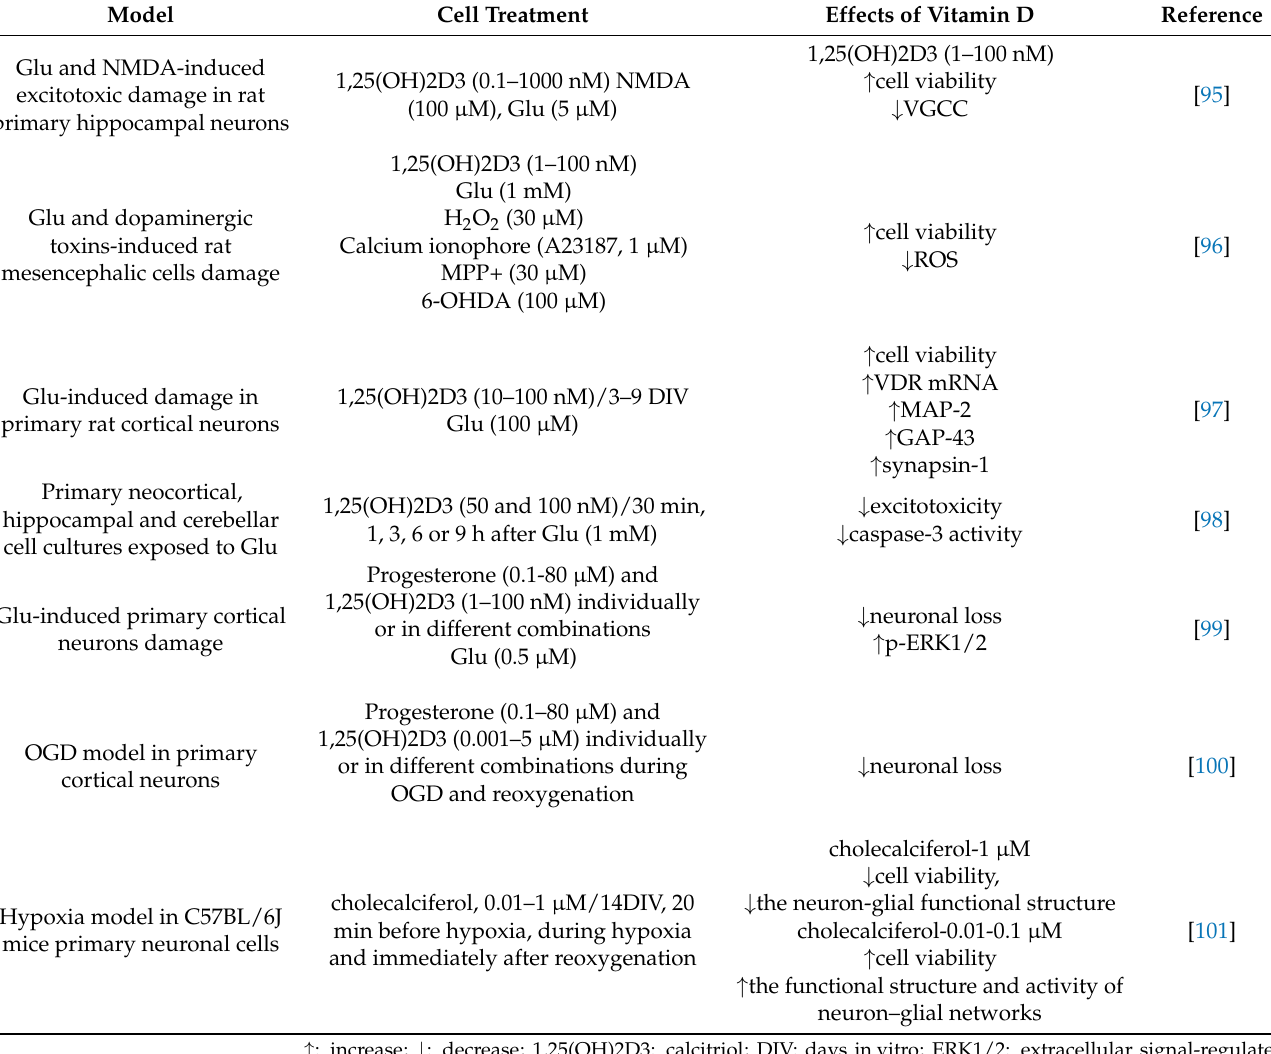
Table 1. Effects of vitamin D in experimental stroke models—in vitro